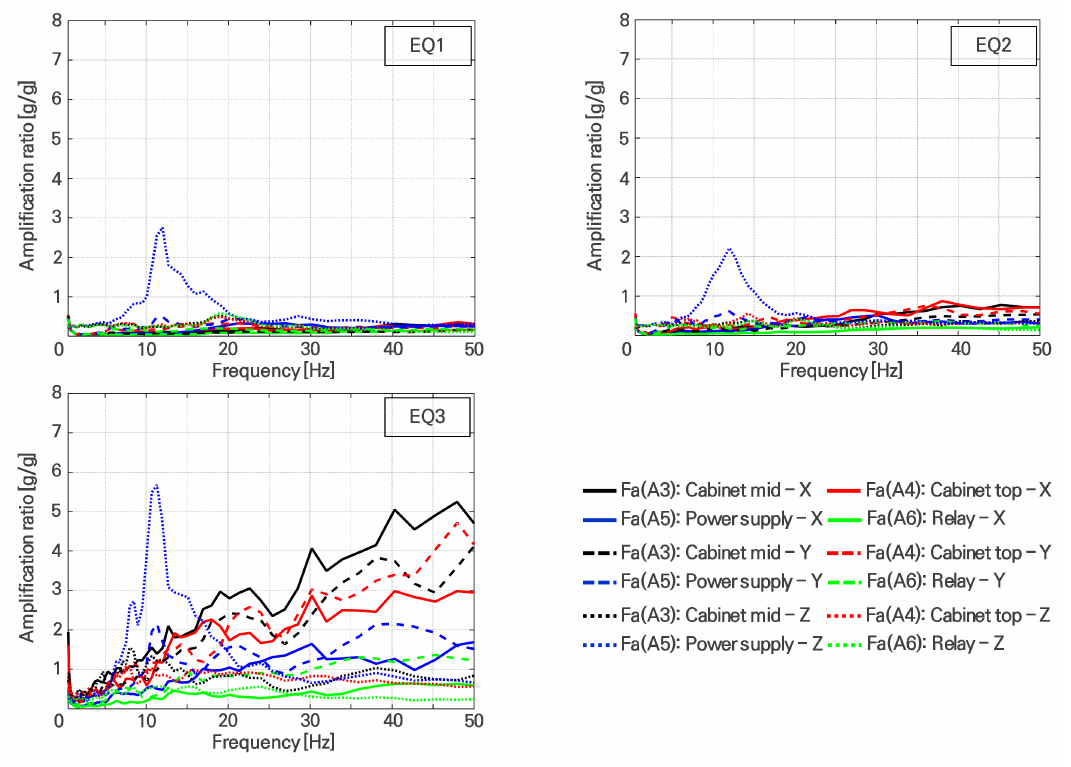
Figure 15. F a values for Case 2. Table 11. Peak value of F a at ZPA of 50